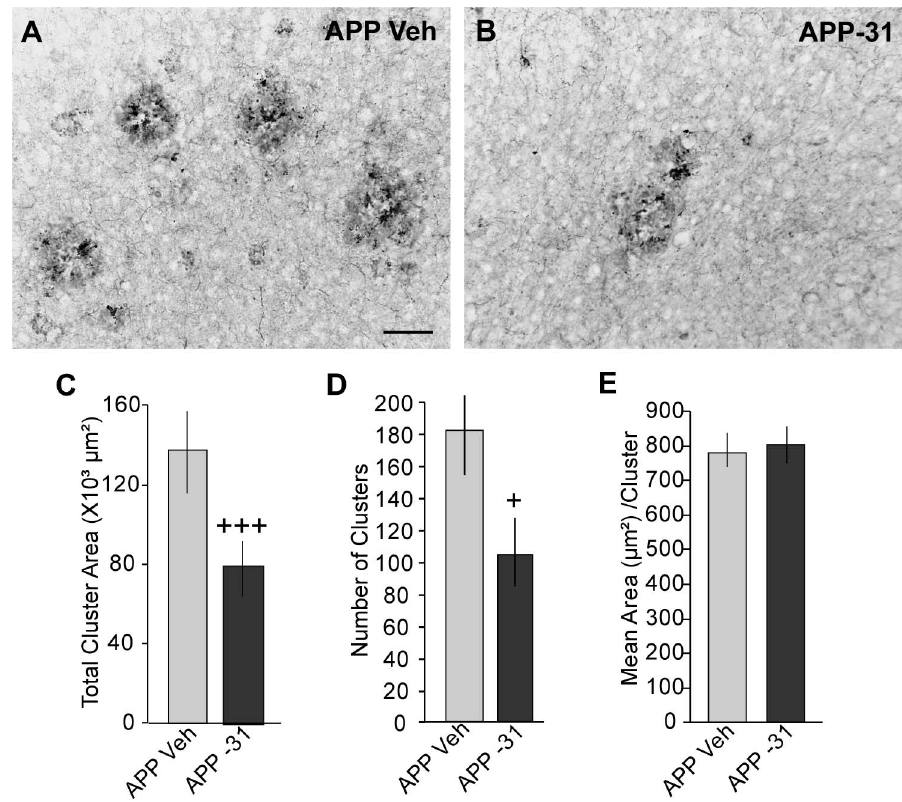
Figure 6. LM11A-31’s effect on cholinergic dystrophic neurites in cortex of mid-stage APP L/S mice. Representative photomicrographs show ChAT-immunostained dystrophic neurite clusters in the cortex of ( A ) APP L/S (APP) Veh and ( B ) APP-31 mice. Scale bar in photomicrograph A=50 m m. Quantitative analysis showed that LM11A-31 decreases the total area occupied by the clusters ( C ) by decreasing their number ( D ) but not the mean area per cluster ( E ). Statistical significance was determined using a two-tailed Student’s t-test (APP Veh, n=10; APP-31, n=9). + p=0.03 and +++ p=0.001 vs. APP Veh.